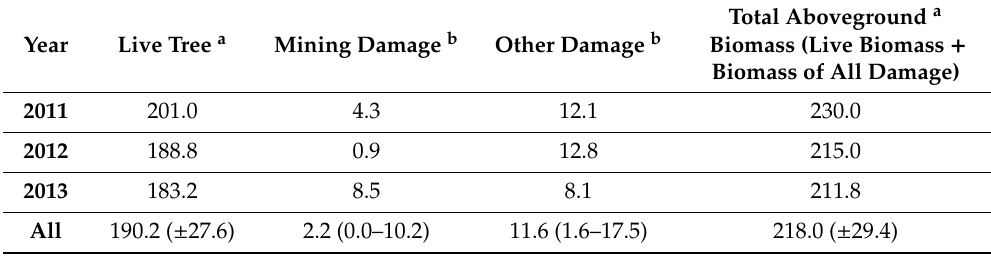
Table 4. The mean carbon content in all live trees and the median carbon content in mining damaged trees and in other damaged trees, all in units of Mg C ha − 1 , by year from 41 transects.